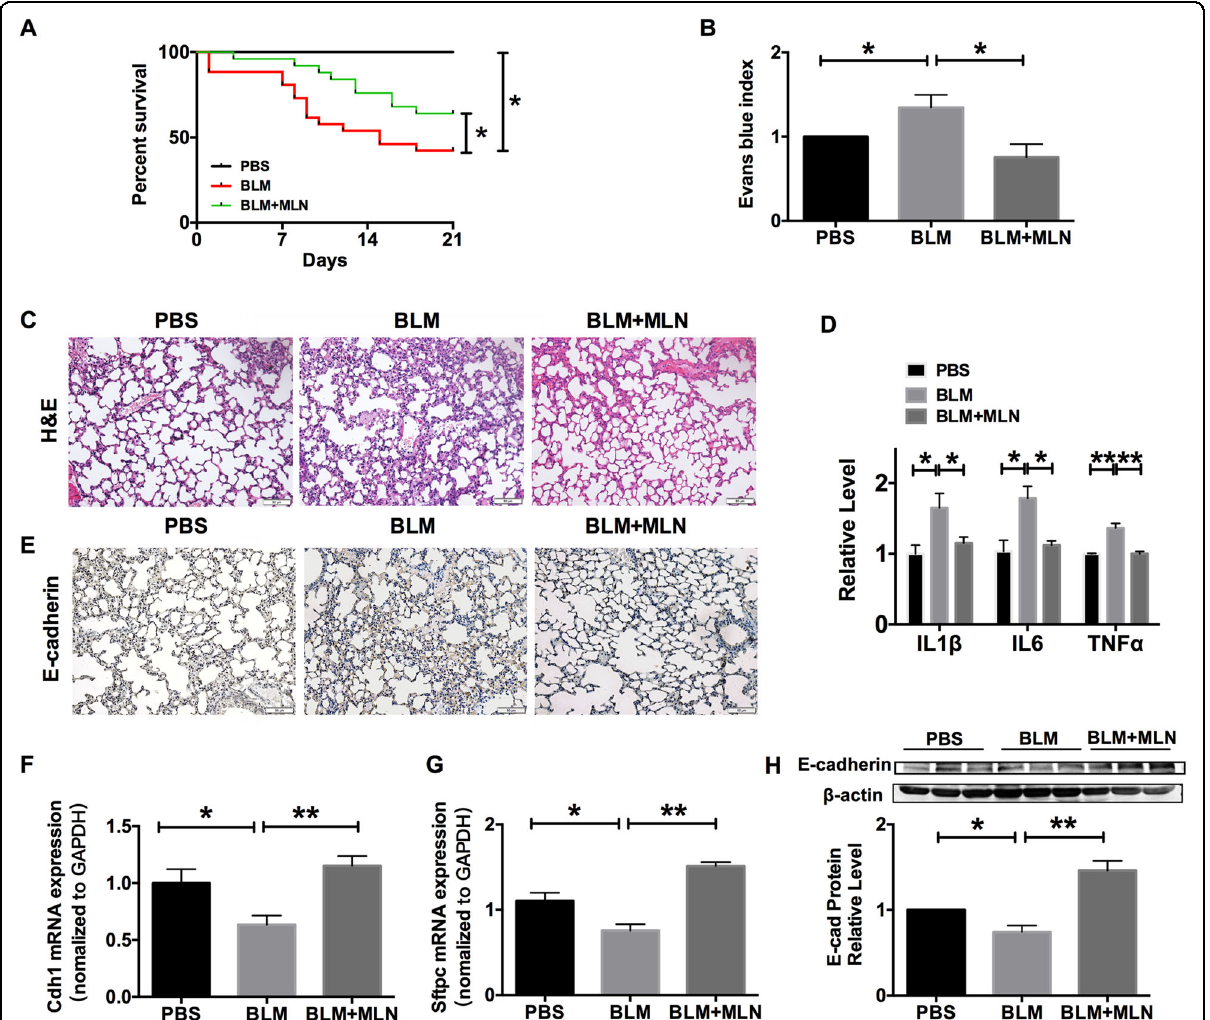
Fig. 1 Melatonin increased survival and improved pulmonary epithelial function in response to bleomycin. Mice were intratracheally treated with PBS or bleomycin (BLM) with or without melatonin (MLN), (PBS group: n = 25, BLM group: n = 26, BLM + MLN group: n = 25). a Survival plots of mice in the PBS, BLM, and BLM + MLN groups. * P < 0.05. b Mice were intraperitoneally injected with Evans blue solution (1 ml/kg 3% Evans blue solution in PBS) for 30 min before euthanization. The amount of Evans blue was measured in the whole lungs of mice in the PBS, BLM, and BLM + MLN groups and normalized to the Evans blue concentration in methanamide to generate an Evans blue index. n = 3; * P < 0.05. c H&E staining of representative lung sections from mice in the PBS, BLM, and BLM + MLN groups. Scale bars, 50 μ m. d The mRNA expression of in fl ammatory factors (IL1 β , IL6, and TNF α ). n = 4; * P < 0.05, ** P < 0.01. e The Immunohistochemical assay of E-cadherin in lung samples from mice in the PBS, BLM,